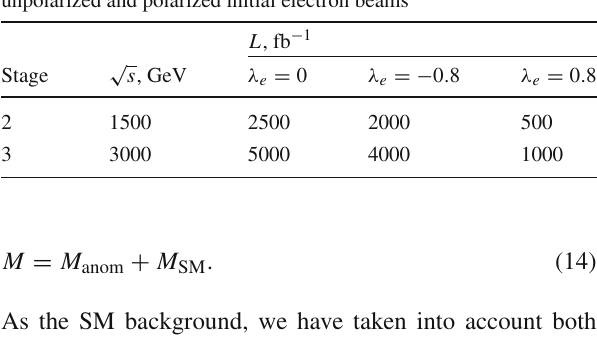
TheLBLscatteringoftheCBphotonshappensasshownin Fig.1.Itsdifferentialcrosssectionisexpressedintermsofthe